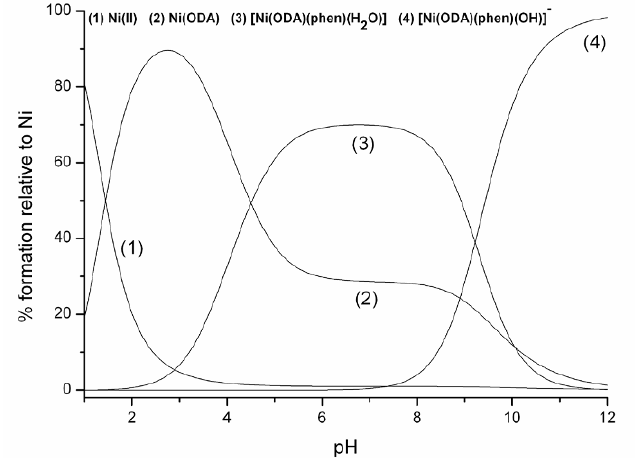
Figure 2. Concentration distributions of Ni(II) (1), Ni-ODA (2), [Ni(ODA)(phen)(H the Ni(II) – H ODA – phen system. 2